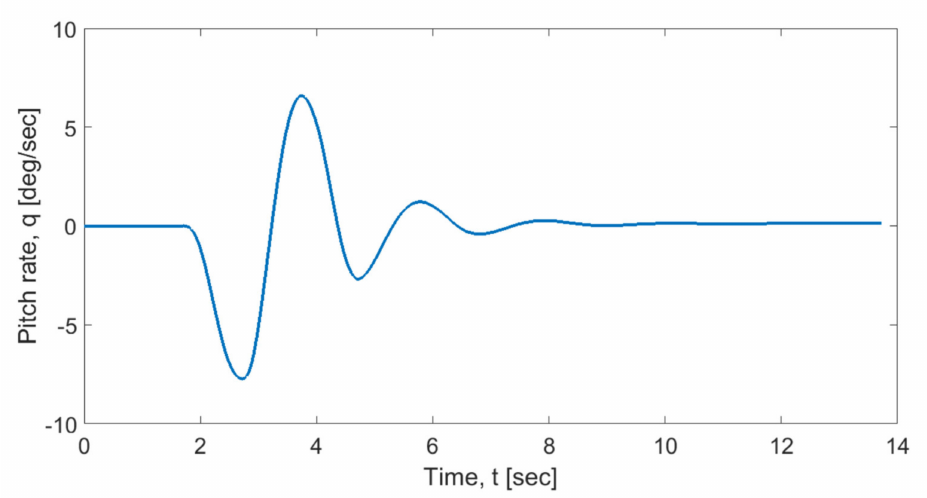
Figure 11. In flight body axis pitch rate recording for short period mode at cruise